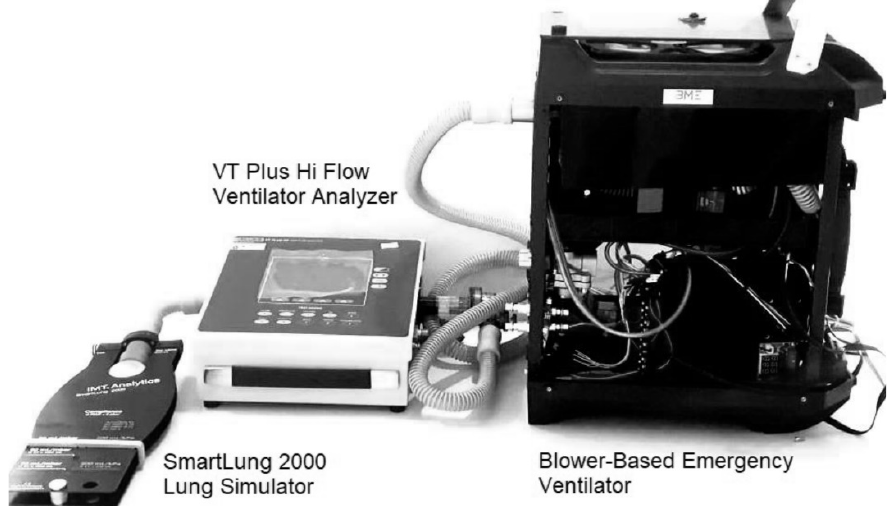
Figure 18. Performance test setup, showing the SmartLung 2000 lung simulator attached to air outlet of VT Plus Hi Flow ventilator analyzer and air inlet attached to the blower-based emergency ventilator. Table 8. Performance testing condition of pressure-control